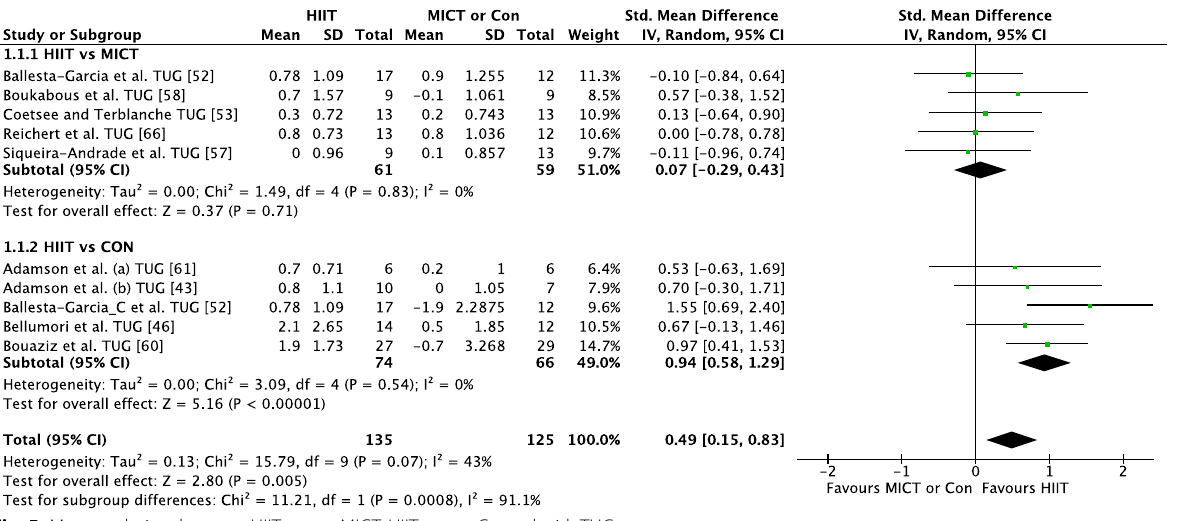
Fig. 5 Meta-analysis subgroups HIIT versus MICT, HIIT versus Control with TUG outcome